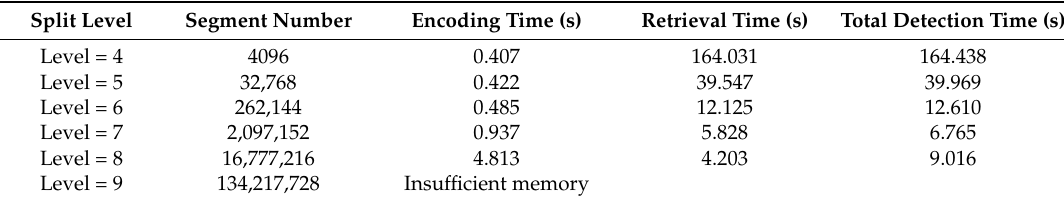
Figure 21. The relationship between the level of split times and the detection time. Table 1. Detection